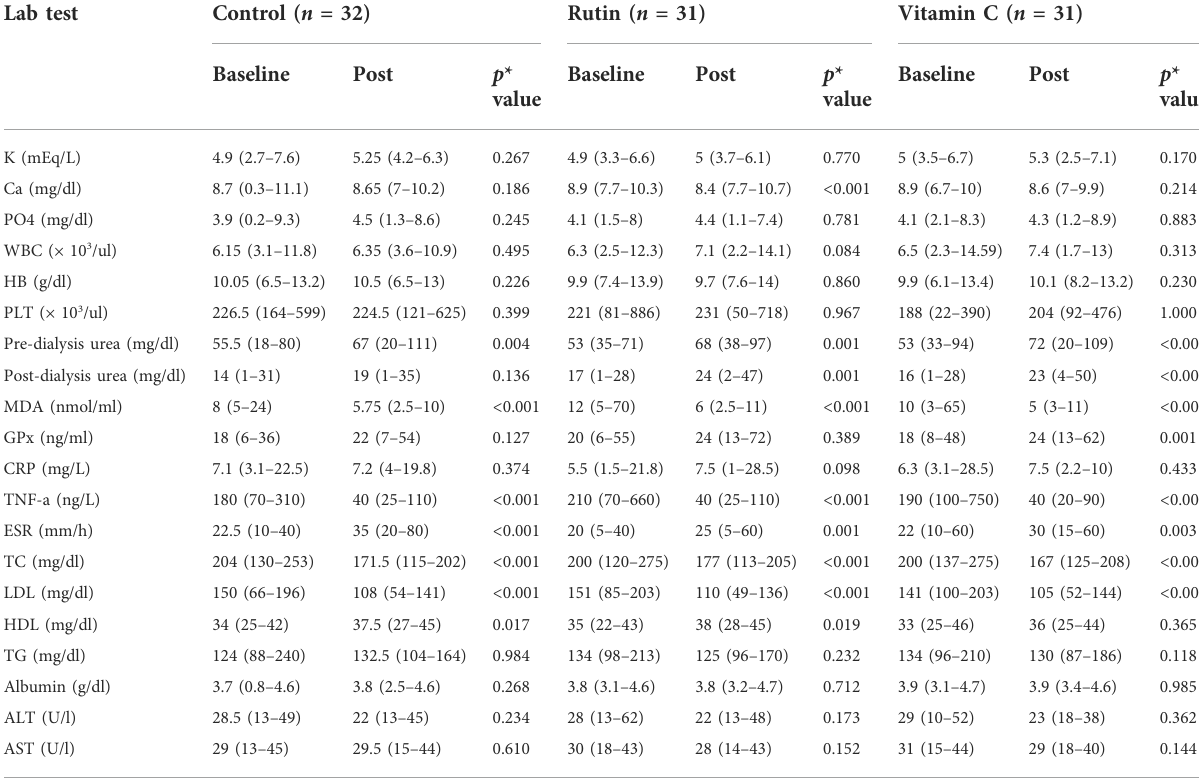
TABLE 3 Values of laboratory parameters and markers of oxidative stress before and at the end of the study period among the studied groups. Lab